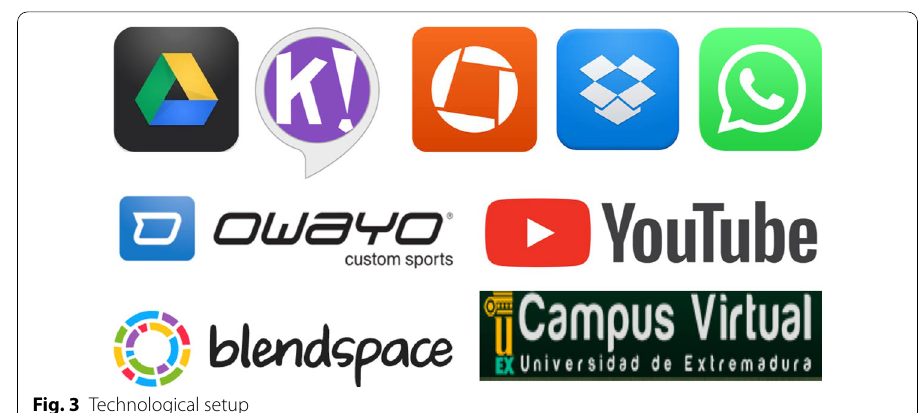
Fig. 3 Technological